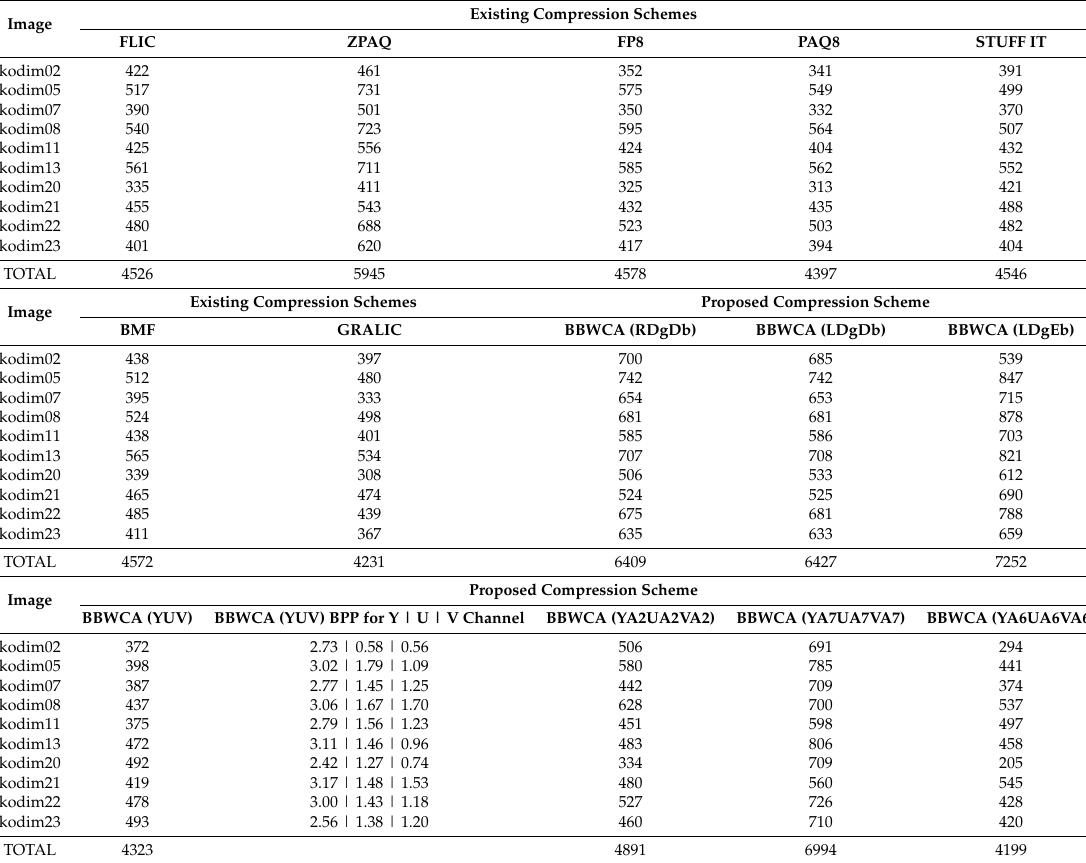
Table 2. Comparative Analysis of Compression sizes achieved in KB with existing benchmark schemes (for Kodak images). All Kodak images have a resolution of 768 × 512 × 3 totaling 1152 KB. BPPs for separate Y, U, V channels for the BBWCA(YUV) transform are shown for individual channel